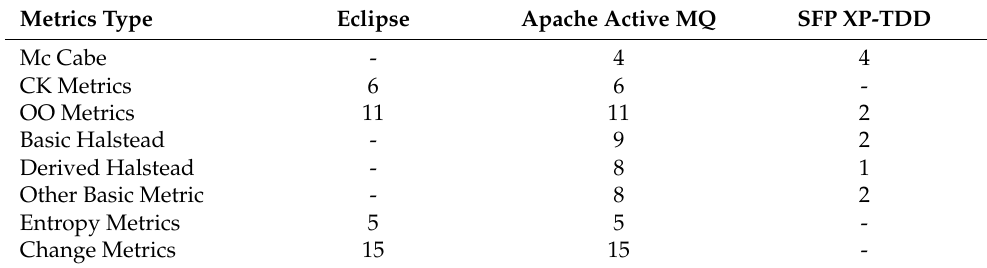
Table 6. The general metrics type information of all data